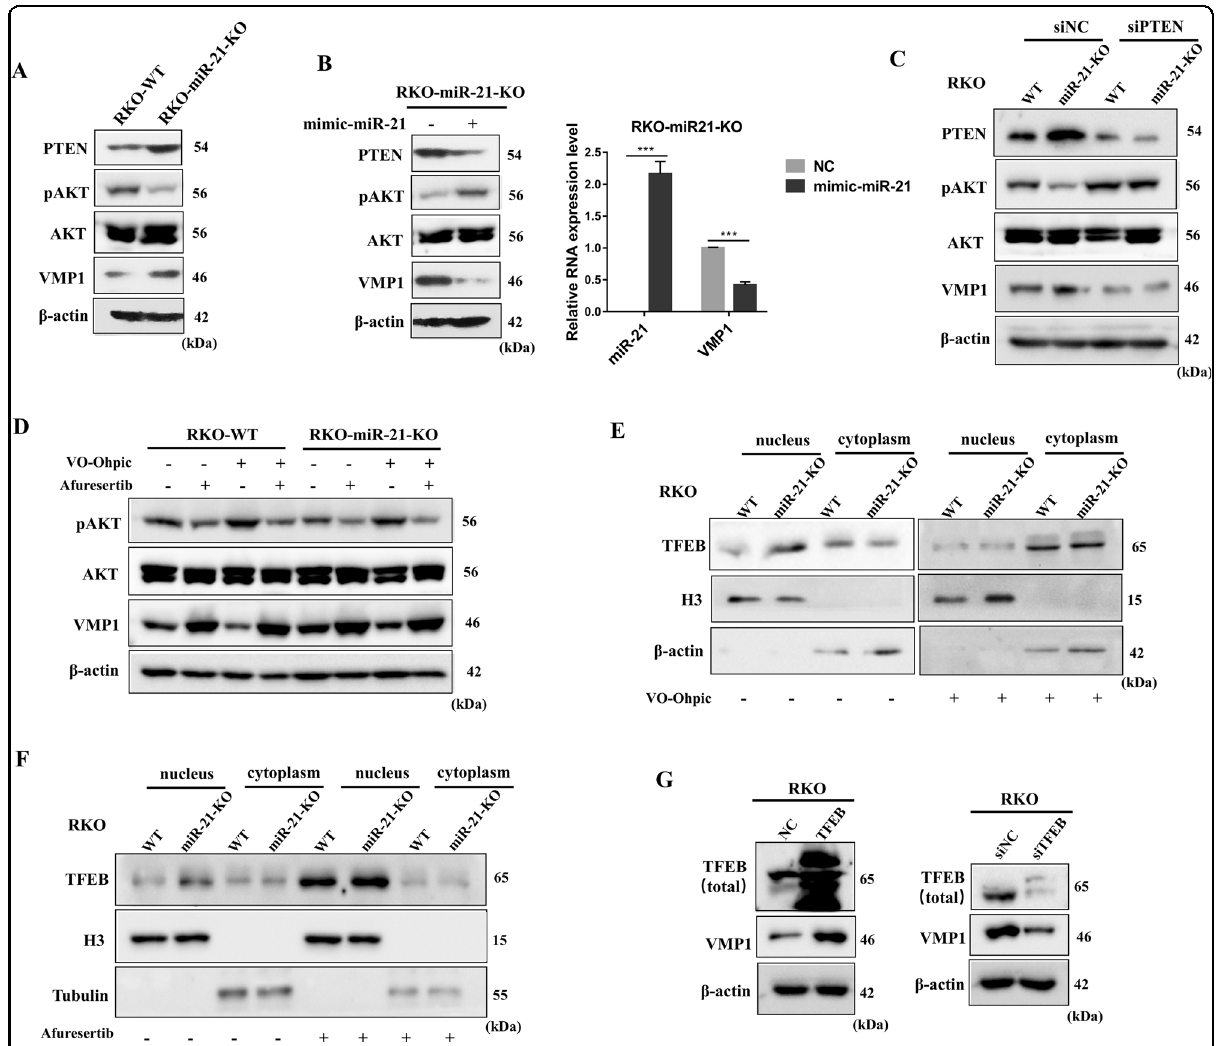
Fig. 3 miR-21 inhibits VMP1 expression through PTEN/AKT/TFEB pathway. a The protein expression level of PTEN, phosphorylated AKT (Ser473), total AKT, and VMP1 were measured by Western blot. b RKO-miR-21-KO was transfected with miR-21 nucleotide mimic, and the mRNA expression level of miR-21 and VMP1 was measured by qPCR, the protein expression level of PTEN, phosphorylated AKT (Ser473), total AKT, and VMP1 were measured by Western blot. c RKO and RKO-miR-21-KO were transfected with siRNA targeting PTEN respectively, the protein expression level of PTEN, phosphorylated AKT (Ser473), total AKT, and VMP1 were measured by Western blot. d RKO and RKO-miR-21-KO were treated with 2 µM VO-Ohpic and 1 µM Afuresertib for 24 h, the protein expression level of phosphorylated AKT (Ser473), total AKT, and VMP1 in after were measured by Western blot. e RKO and RKO-miR-21-KO cells with no treat or treat with 2 µM VO-Ohpic for 24 h, the protein level of TFEB in cytoplasm and nucleus respectively was measured by Western blot, H3 and β -actin were used as nuclear and cytosolic markers, respectively. f RKO and RKO-miR-21-KO cells with no treat or treat with 1 µM Afuresertib for 24 h, the protein level of TFEB in cytoplasm and nucleus respectively was measured by Western blot, H3 and Tubulin were used as nuclear and cytosolic markers, respectively. g The protein expression level of TFEB and VMP1 were measured by Western blot after overexpression of the constitutively active TFEB by pCIP-caTfeb vector or knock-down of TFEB expression by siRNA in RKO cells. Data are presented as mean ± SD. *** P <